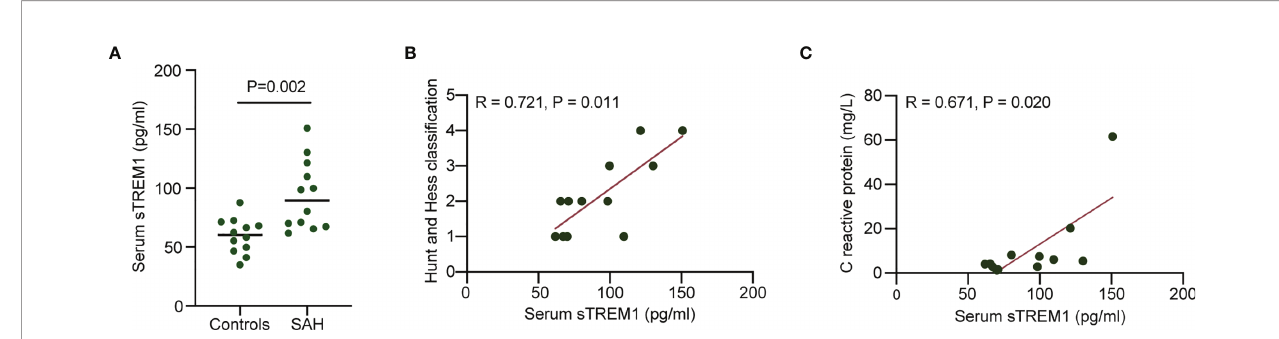
FIGURE 1 | Increased plasma levels of sTREM1 in patients with aneurysmal SAH. (A) . The levels of plasma sTREM1 were quanti fi ed by ELISA in blood collected from control patients (n = 12) or patients with aneurysmal SAH (n = 12). P values are shown as insets. (B , C) . Correlation analysis between patient plasma sTREM1 and Hunt and Hess classi fi cation score or C reactive protein. Spearman ’ s rank correlation coef fi cient (R) and P value are shown as